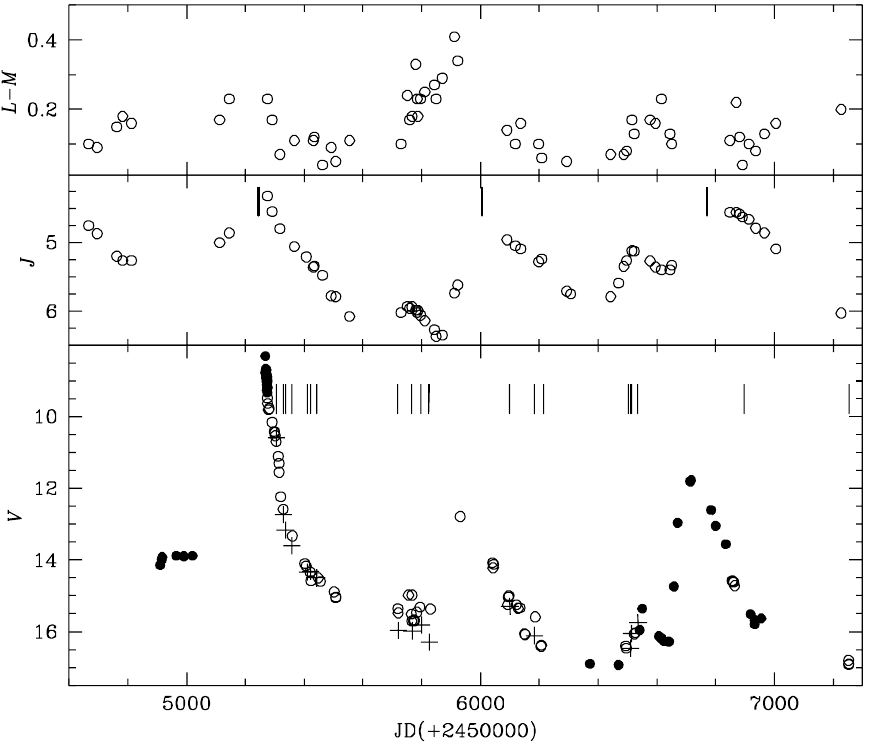
Fig. 1. The V; J light curves and L (cid:0) M color curve for V407 Cyg. Open circles are our photometric observations; dots denote AAVSO data; crosses are estimates obtained from our spectroscopic observations. The vertical bars above the V -band light curve mark the dates of our spectroscopic